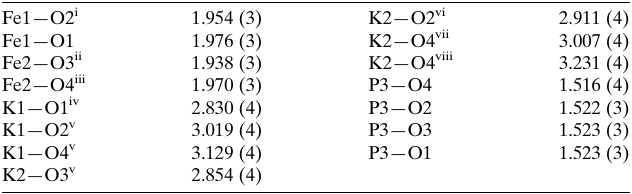
Table 1 Selected bond lengths (A˚ ) for (I).